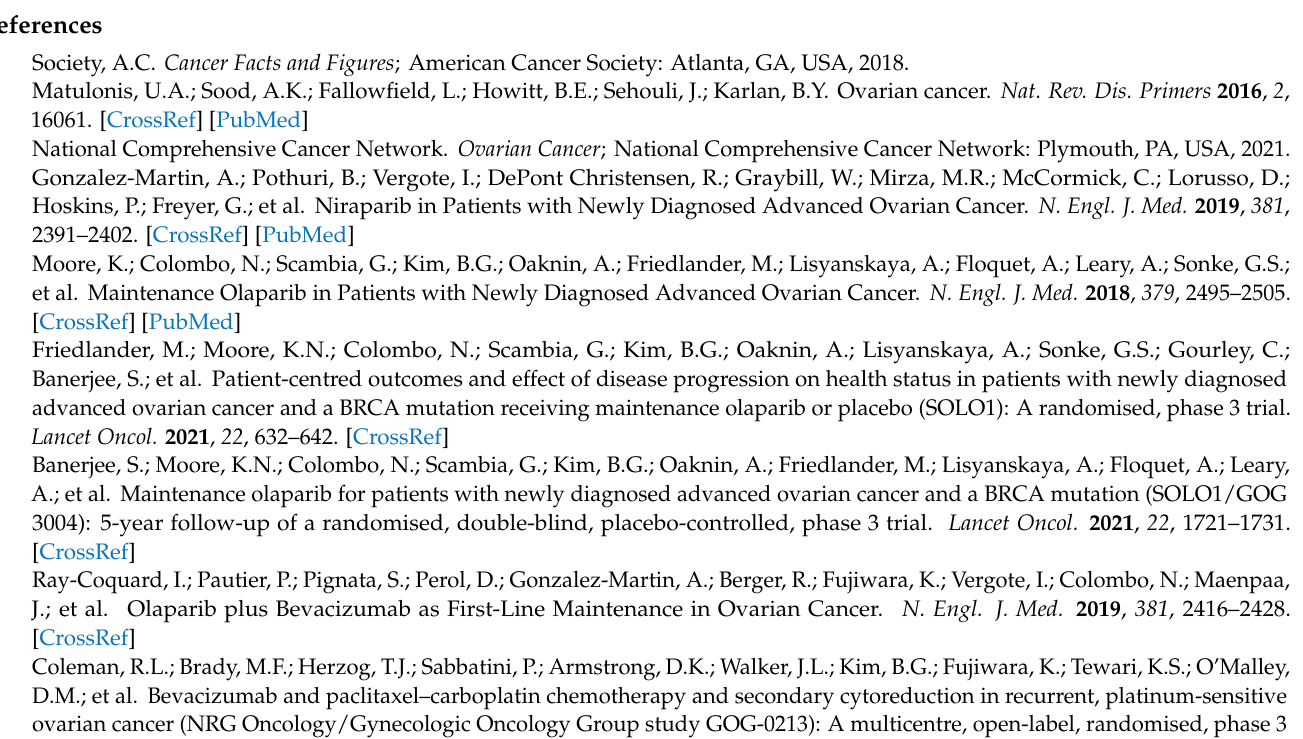
ascites and metastases STOSE.M1 luc samples, Figure S8: Representative T Memory Panel Gating Strategy used to assess primary tumor, ascites and metastases STOSE.M1 luc samples, Figure S9: FlowSOM analysis of myeloid markers on CD45 + immune populations, Figure S10: Representative Myeloid Panel Gating Strategy used to assess primary tumor, ascites and metastases STOSE.M1 luc samples, Figure S11: Representative DC Panel Gating Strategy used to assess primary tumor, ascites and metastases STOSE.M1 luc samples, Table S1: Antibodies used in this paper, Table S2: Immune cell markers used to gate sub-populations of immune